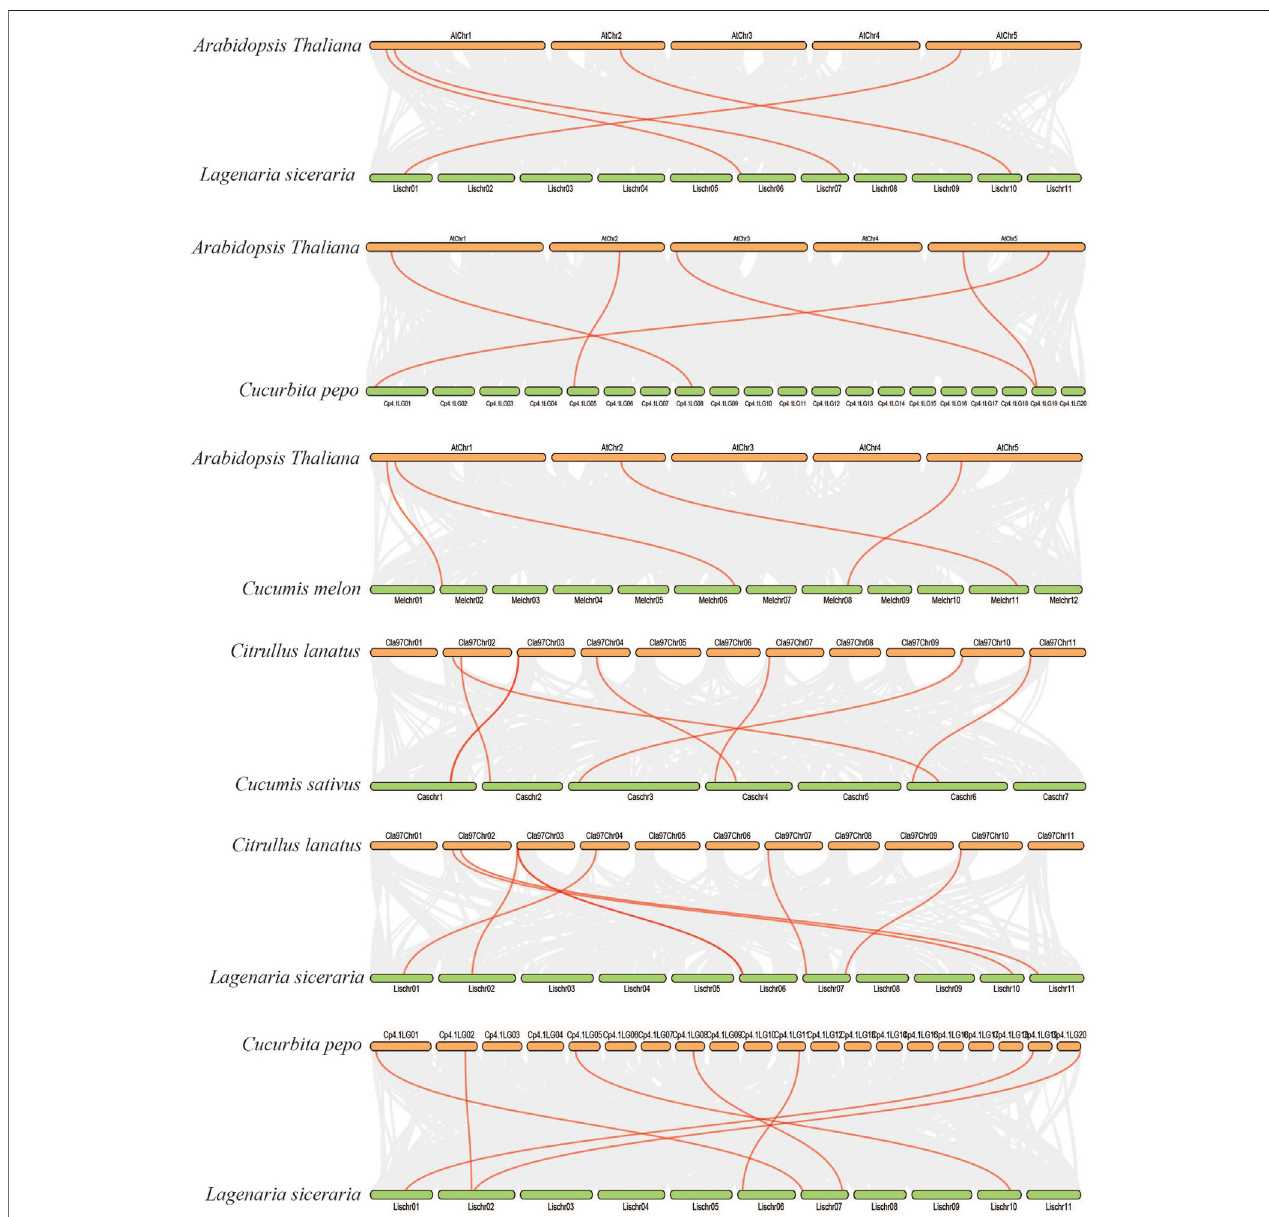
FIGURE 7 | Collinearity relationships in fi ve Cucurbitaceae genomes and Arabidopsis thaliana ; different line color represents synteny relationships in the fi ve Cucurbitaceae genomes.